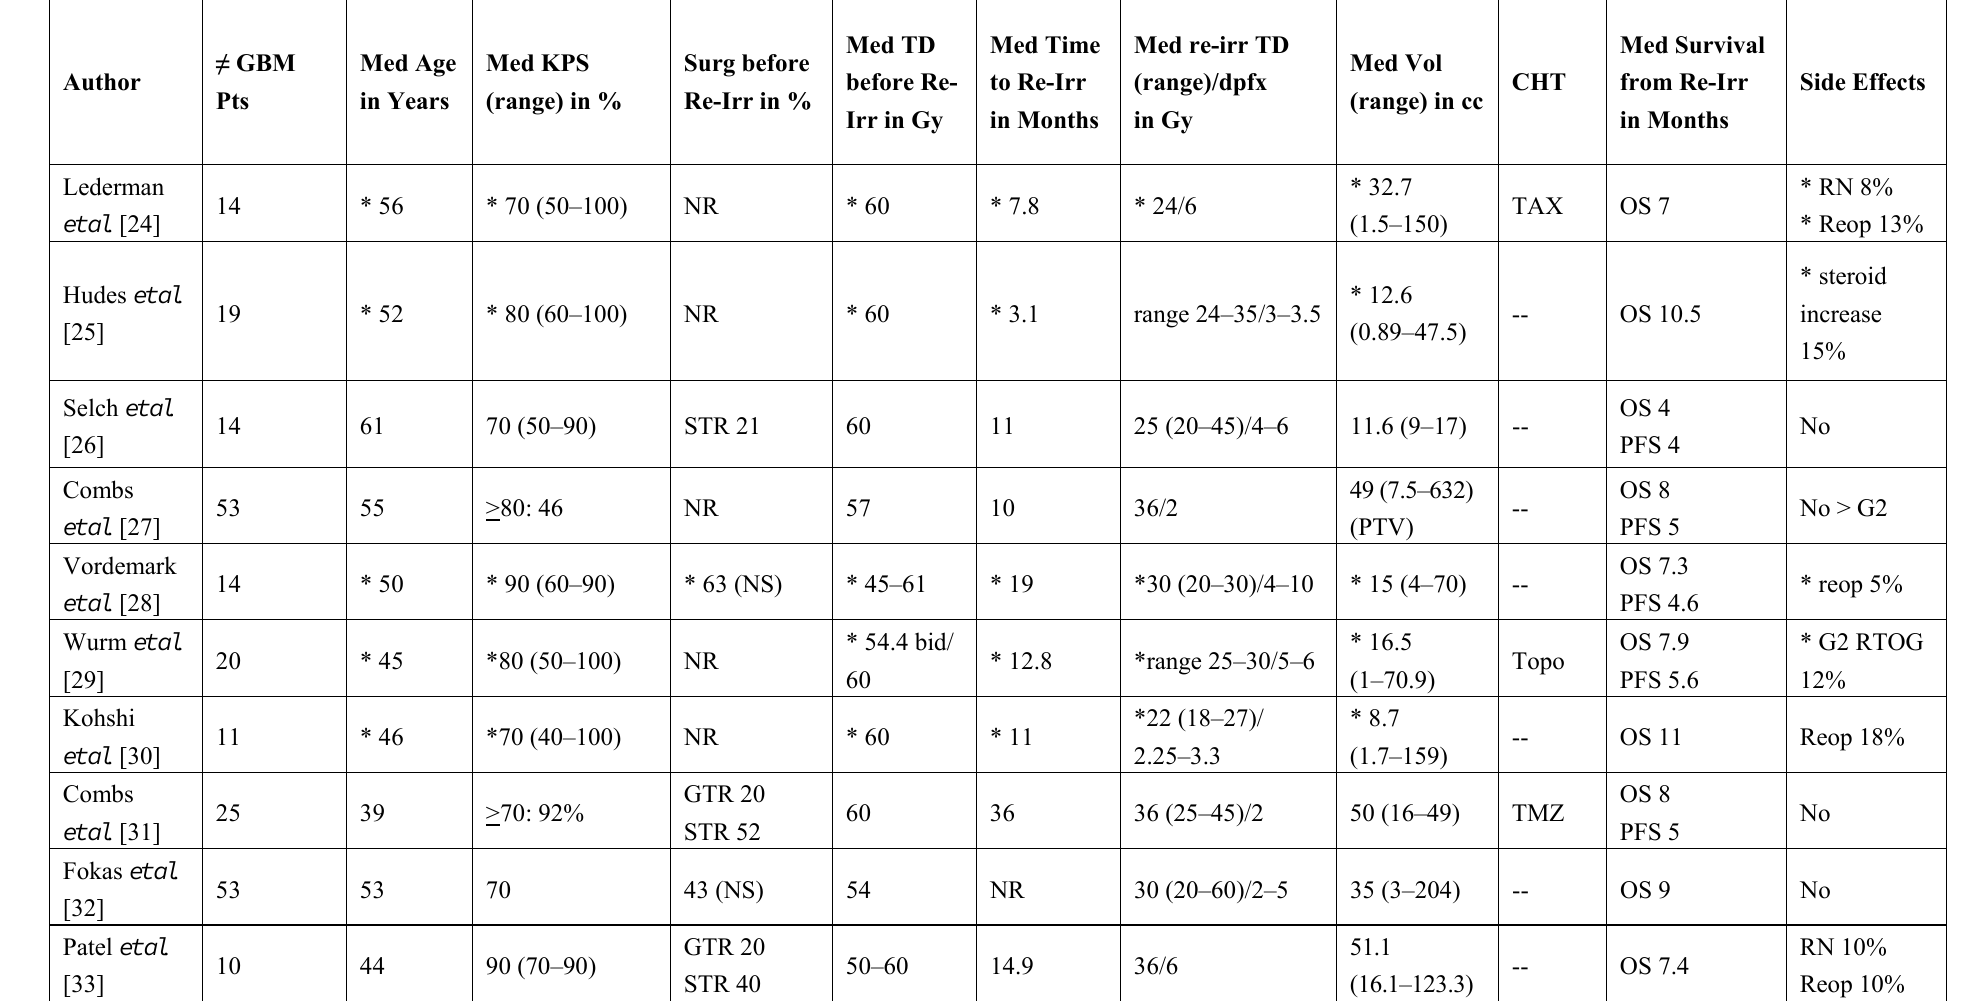
Table 1. Re-irradiation series employing fractionated stereotactic radiation